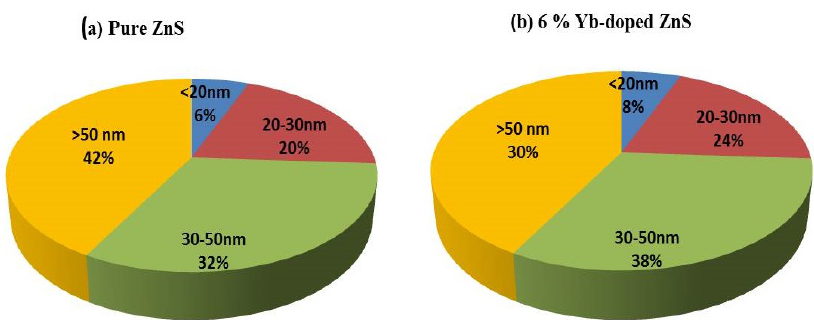
Fig. 5. Size distribution of ZnS (a) and 6 % Yb 3+ -doped ZnS (b) nanomaterials